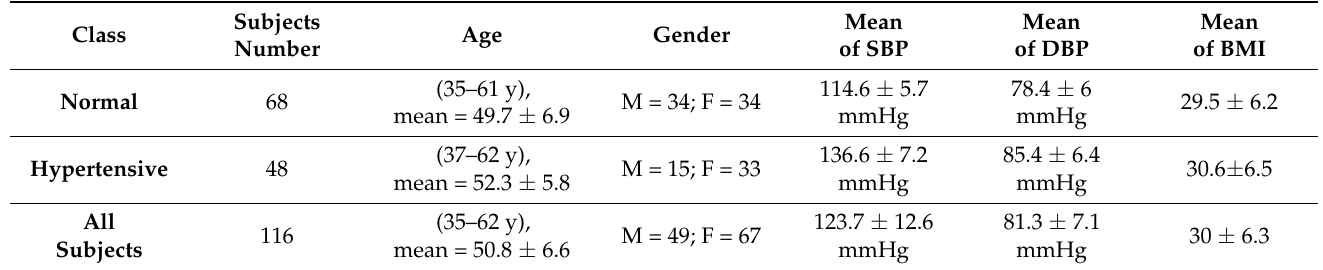
Table 1. Systolic BP-based dataset demographics statistics.